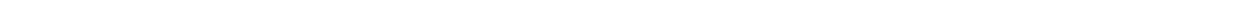
Fig. 2 Proteomic identi fi cation of patients with high CTL invasion reveals that breast cancer invasion does not correlate with neoantigens. a Receiver- operator characteristic plot for prediction of CTL high patients based on neoantigen levels in colorectal cancer patients. Area under the curve (AUC) equal to 0.757 ( N = 64). b Receiver-operator characteristic plot for prediction of CTL high patients based on neoantigen levels in breast cancer patients. Area under the curve (AUC) equal to 0.532 ( N = 80). c CTL score calculated across 19 cancers, plotted in order of median for each cancer. Dots represent individual patients, and lines are median with interquartile range. See Supplementary Fig. 3. Sample sizes given in Supplementary Table 1. d Neoantigens per patient across 19 cancers, plotted in order of median CTL score for each cancer. Dots represent individual patients, and lines are median with interquartile range. Sample sizes given in Supplementary Table 1. e Plot of CTL score as a function of neoantigen load across all patients ( N = 7835). Inset r is Spearman ’ s correlation coef fi cient and corresponding P value. f Pan-cancer analysis of neoantigen-CTL Spearman correlation, with size of dots topping each bar representing signi fi cance level (P). Sample sizes and exact P -values given in Supplementary Table